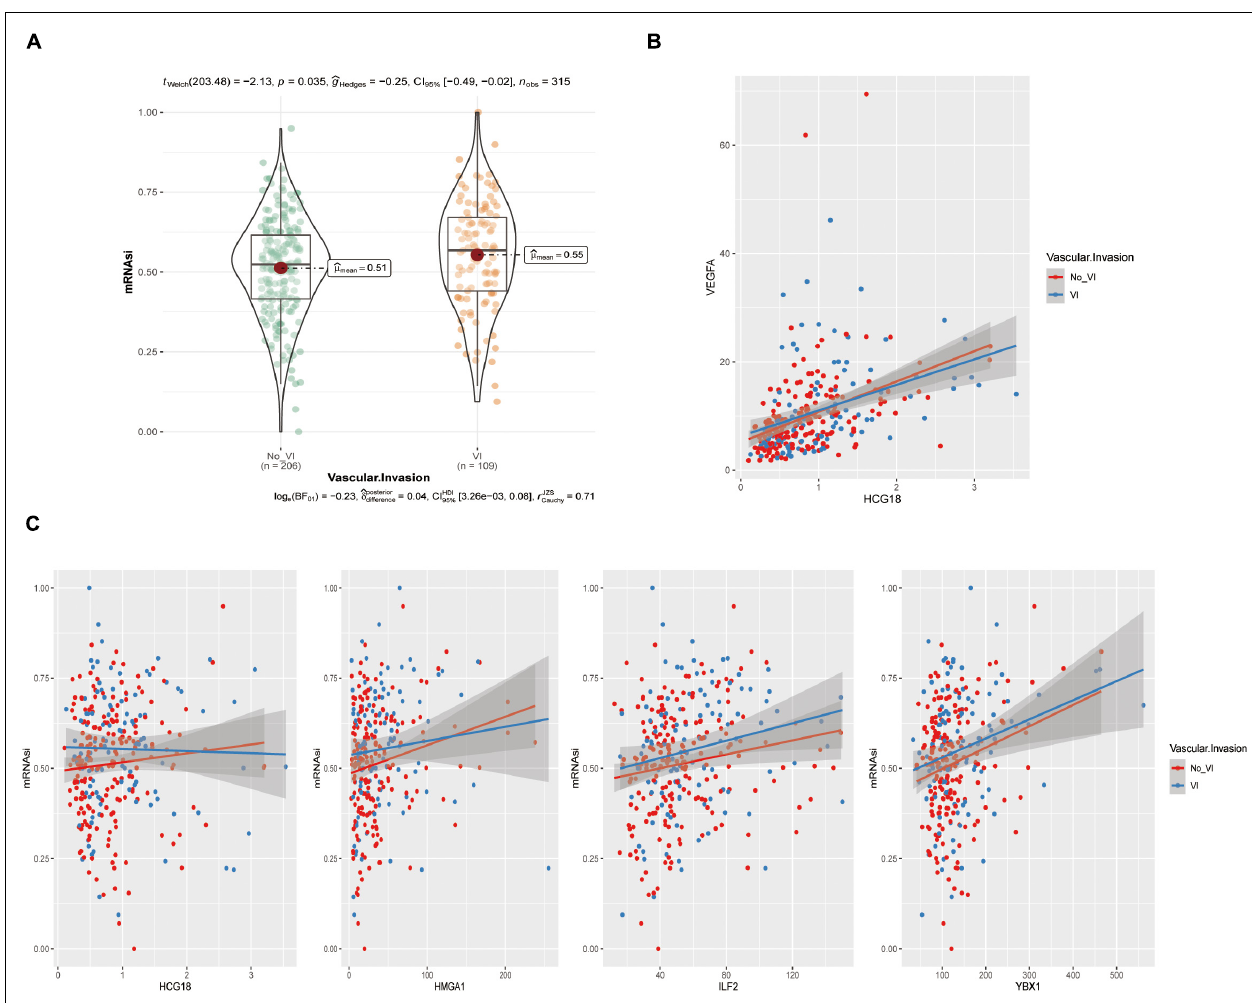
FIGURE 6 | HCG18, HMGA1, ILF2, and YBX1 were positively correlated with tumor stem cell score produced by the OCLR algorithm. (A) Violin plot of stem cell scores in the vascular and non-vascular invasion groups. (B) Scatter diagram of HCG18 and VEGFA expression levels. (C) Scatter diagram of HCG18, HMGA1, ILF2, and YBX1 expression levels and stem cell scores. The regression line indicates a positive